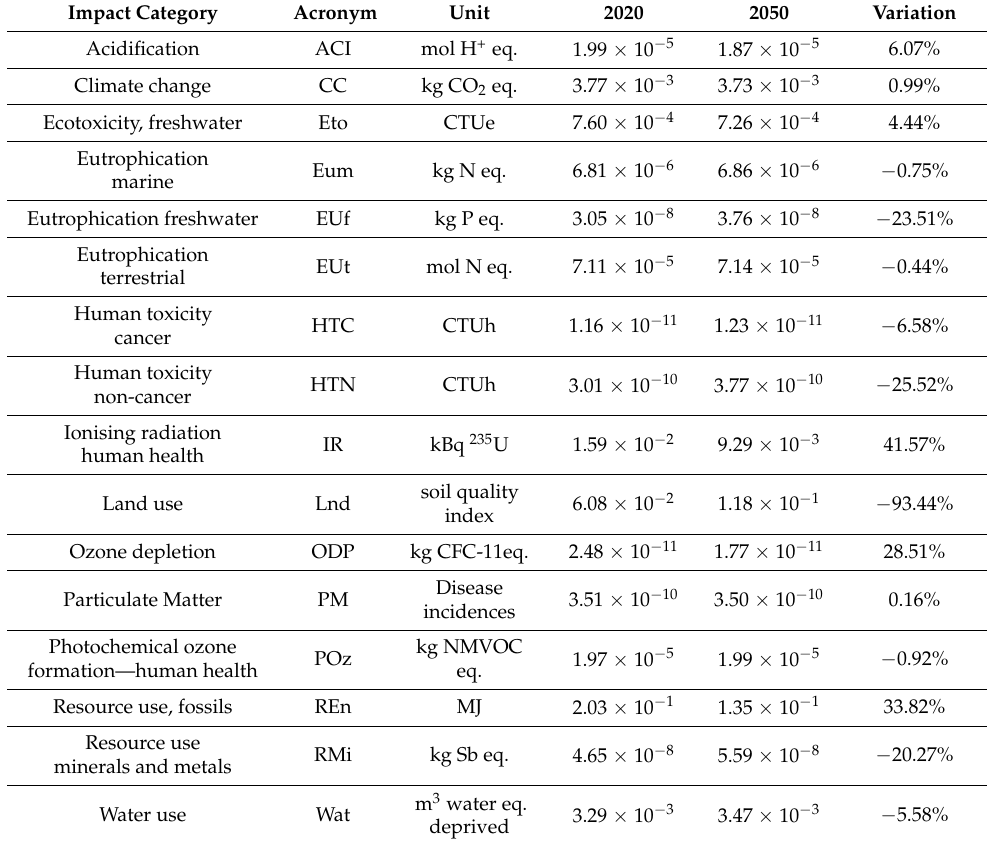
Table 3. Characterized impacts for the 2020 and 2050 electricity mixes. The variation between the 2020 and 2050 results is also reported as percentage. Geothermal source type: liquid, energy conversion technology: direct heat use, load factor: 77%, annual energy output decay: <0.1%, lifetime installation: 30 years, installed capacity: 27 MW th , number of wells: 2 (GRT-1: 2580 mMD, GRT-2: 3938 m total